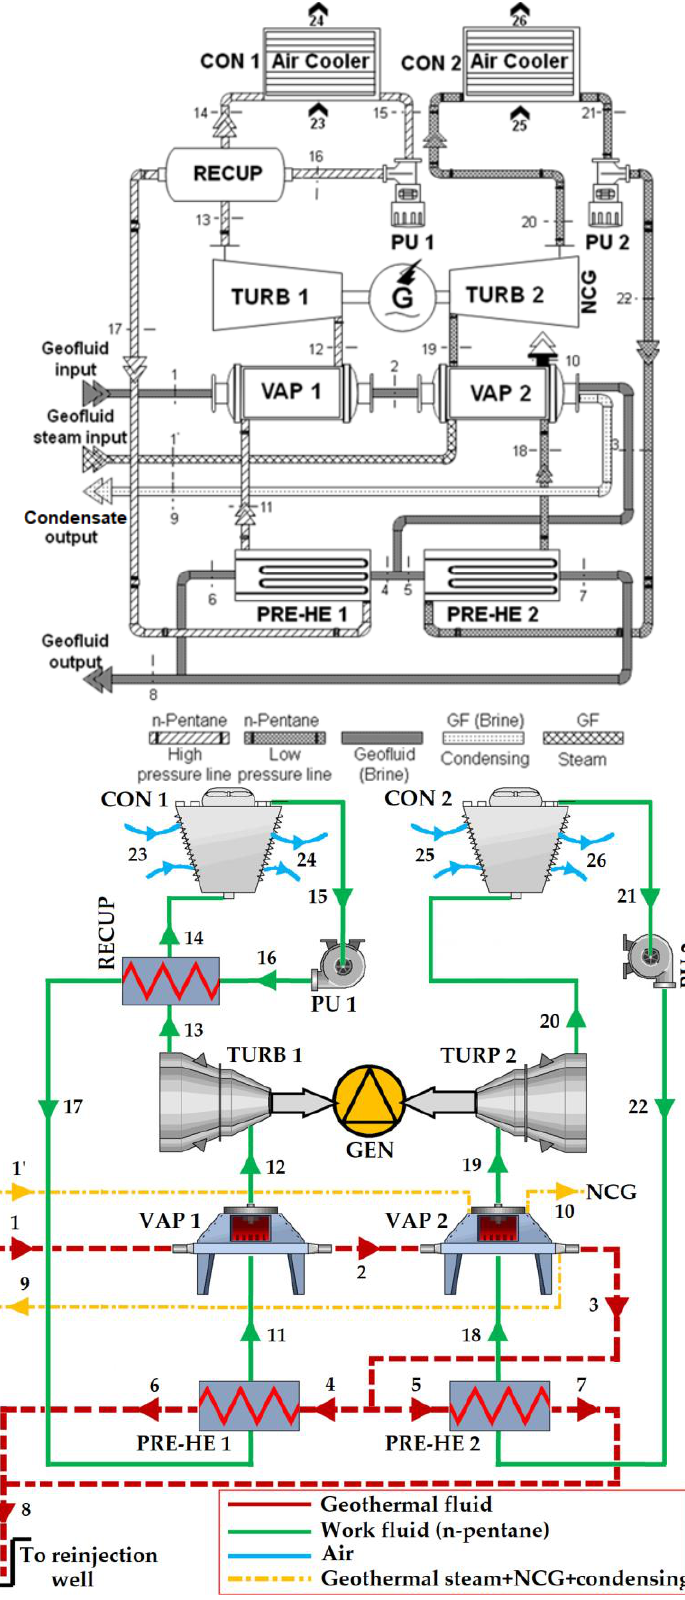
Figure 1. Schematic diagram of the Sinem GPP in Turkey.